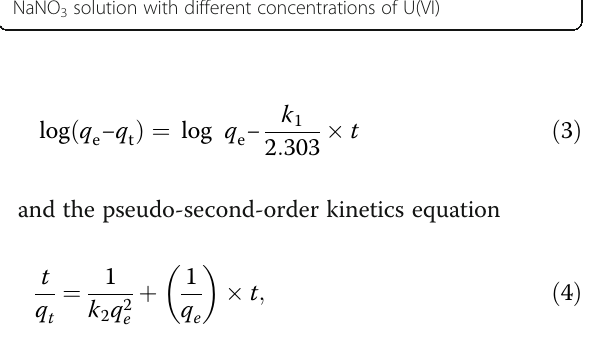
Fig. 8 The surface charge density as a function of pH for the nano-hydroxyapatite ( a ), P-HAP ( b ) and C-HAP ( c ) dispersed in NaNO 3 solution with different concentrations of